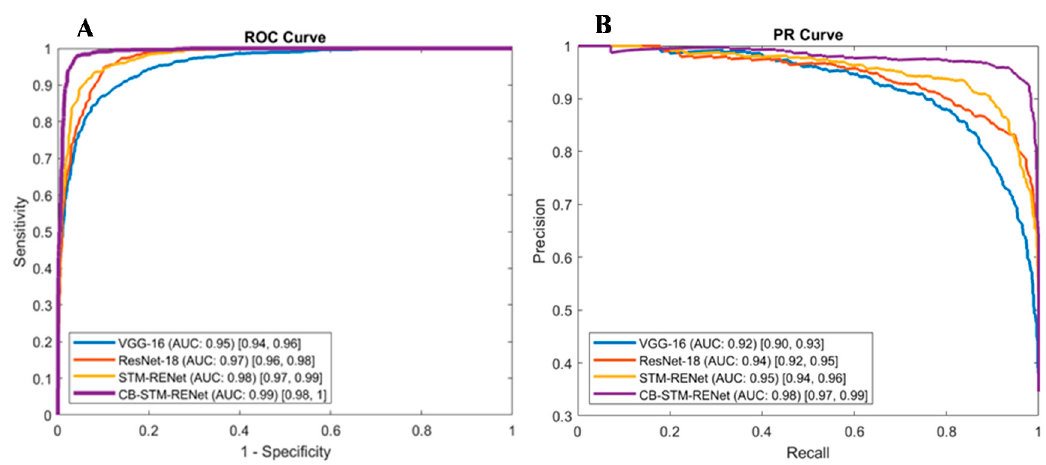
Figure 13. ROC and PR Curve for the proposed CB-STM-RENet, STM-RENet, and existing CNN techniques are reported in panel ( A , B ) for CoV-NonCOV-15k. AUC CI at 95% is shown in square brackets.